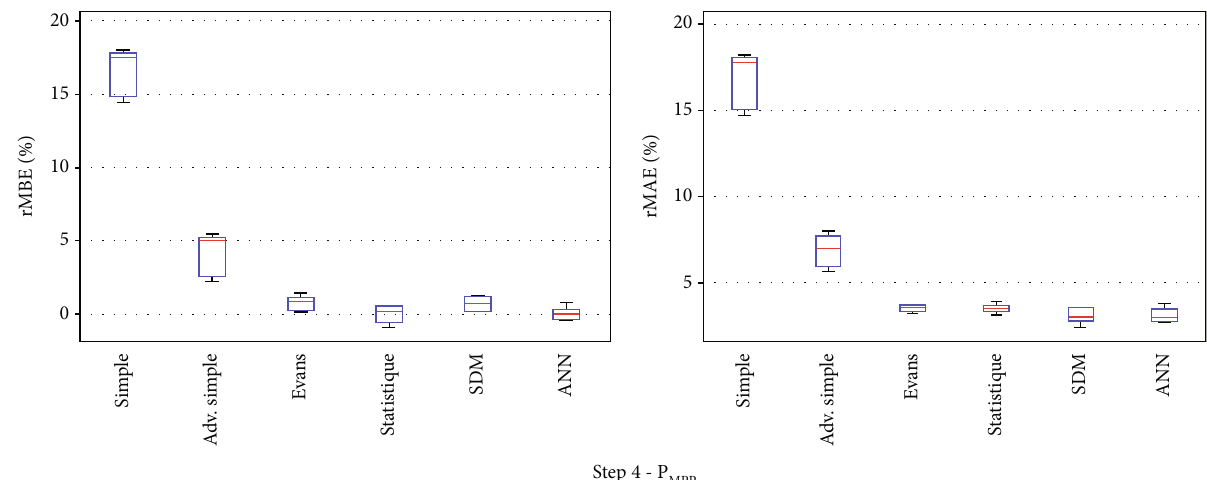
T MPP from GHI and PV . Computed data are summarized in Figure 9 of